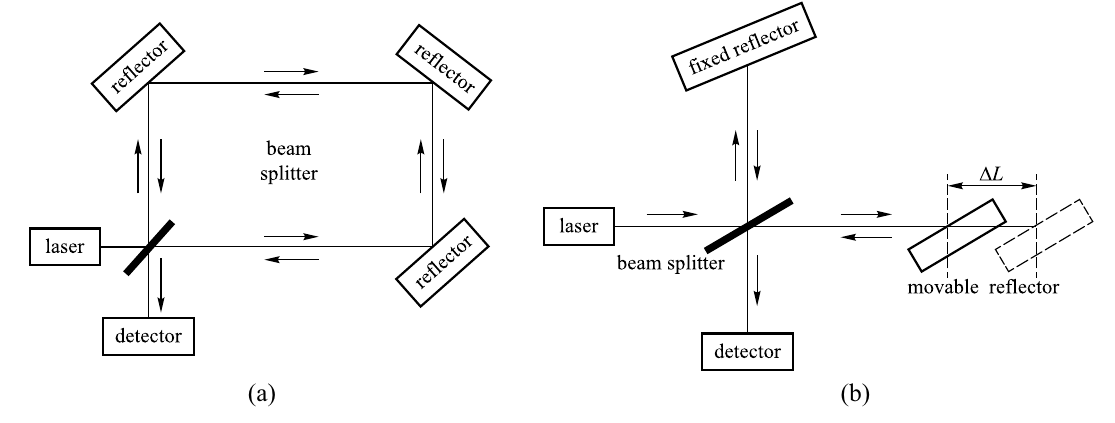
Fig. 9 a Schematic diagram of the Sagnac interferometer. b Schematic diagram of the Michelson